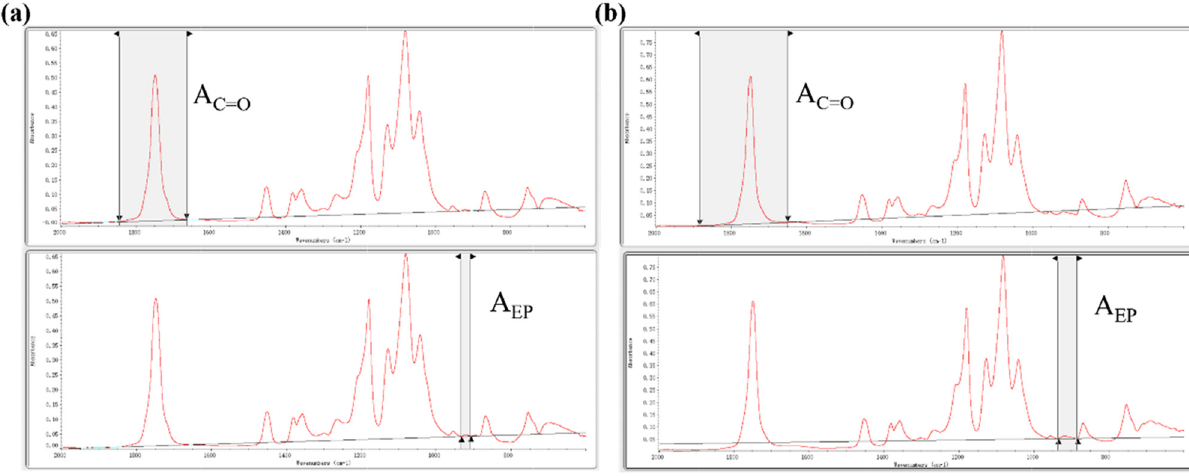
Figure A3: The corrected area of the characteristic peak for epoxy group and carbonyl group in the FT - IR absorbance spectra of ( a ) PLA/ HCCP - EP - 5 and ( b ) PLA/HCCP - EP - 5 ( s ) .